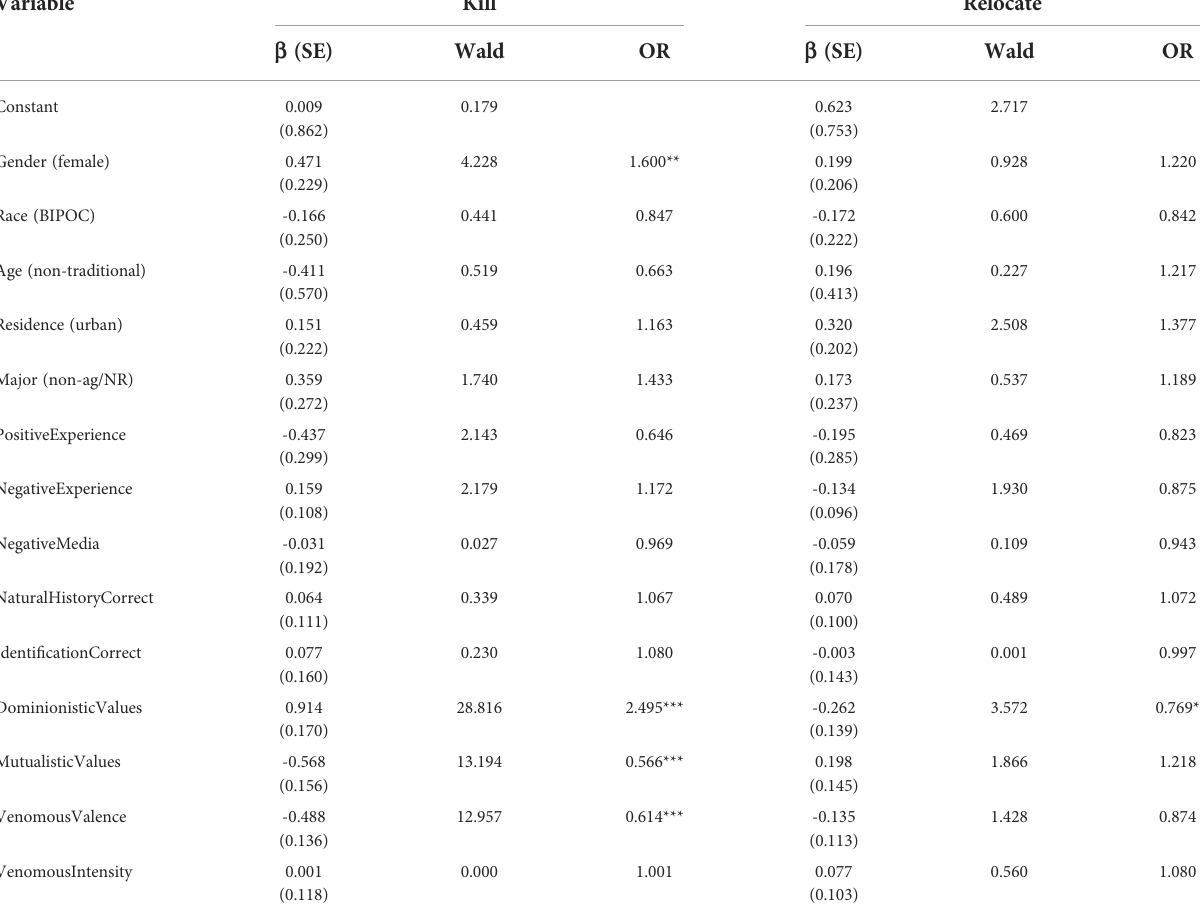
TABLE 3 Parameter estimation from the multinomial logistic regression model predicting tolerance of venomous snakes (measured as reaction to seeing a venomous snake “ right outside of your residence ” ) among college students in North Carolina (n = 743).